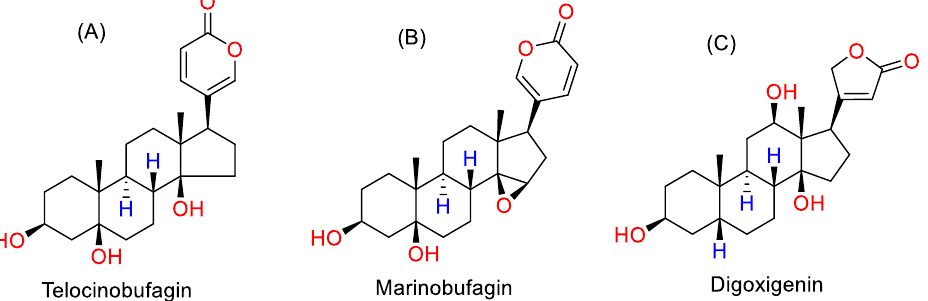
Figure 1. Chemical structures of target CTSs: ( A ) Telocinobufagin (TCB), ( B ) Marinobufagin (MBG) and ( C ) internal standard Digoxigenin (DIG).